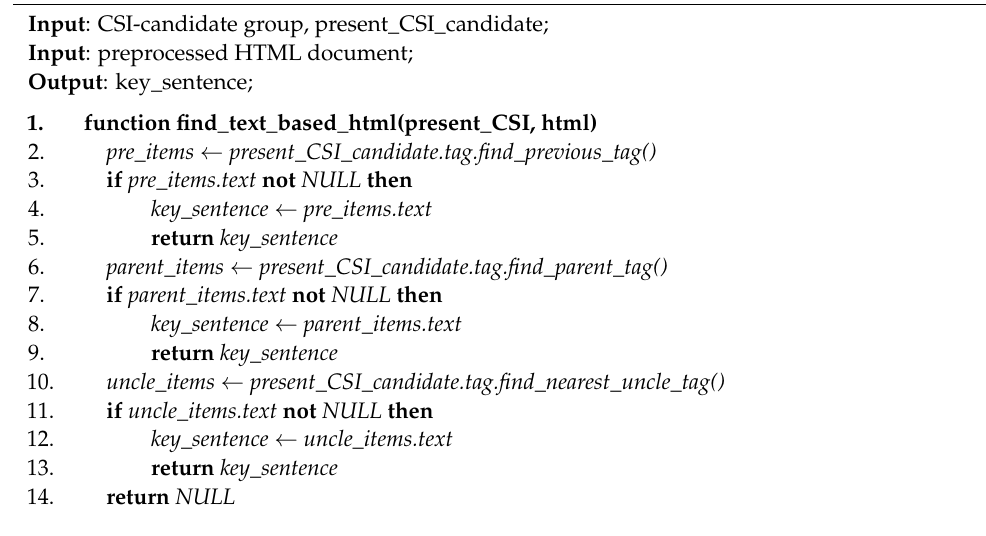
Algorithm 1. HTML-based key sentence location.